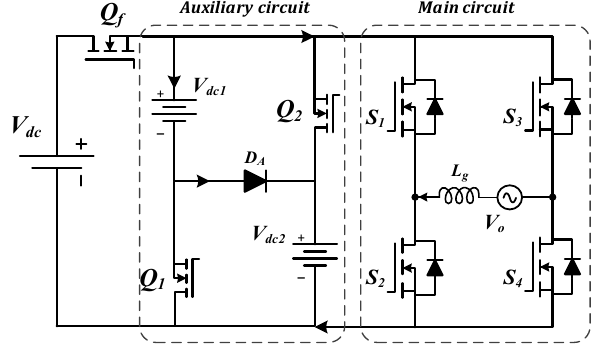
Figure 2. Power circuit of the proposed 7-Level inverter.